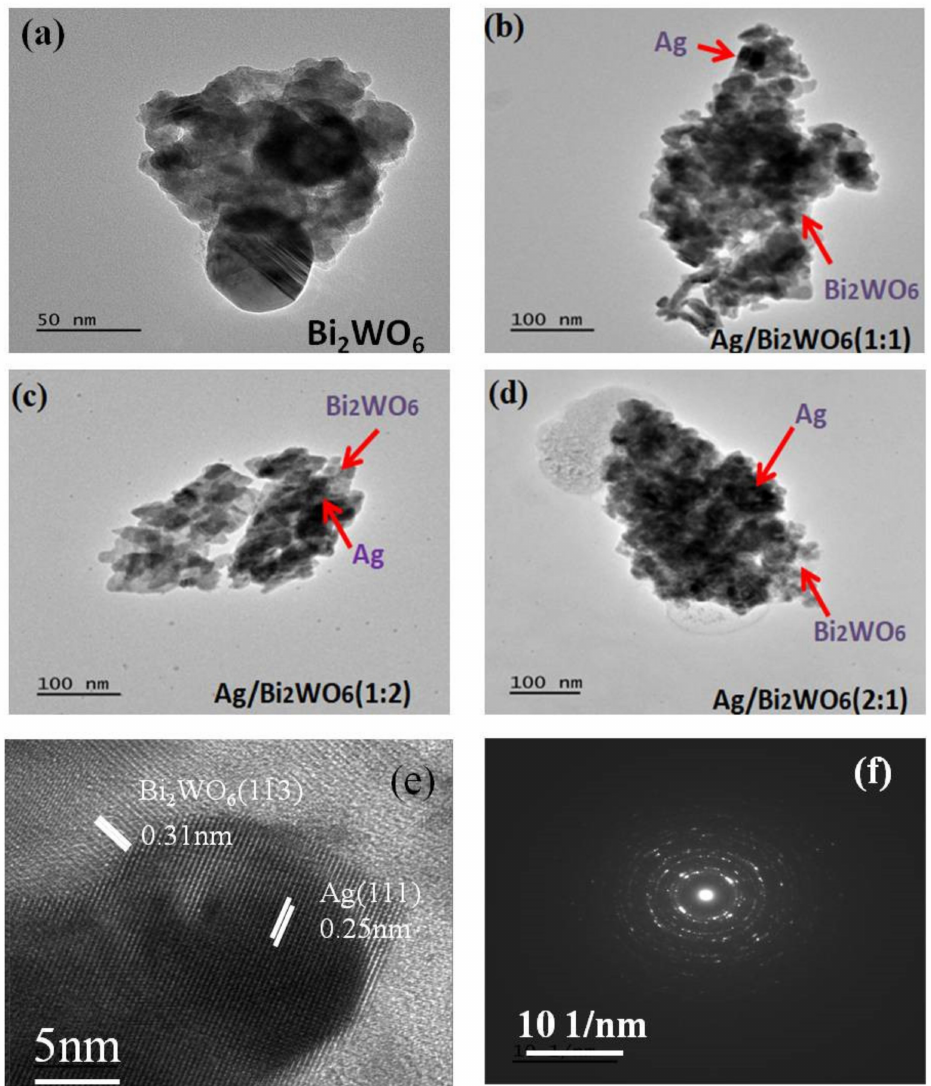
Figure 6. TEM images of ( a ) Bi 2 WO 6 , ( b ) Ag/Bi 2 WO 6 (1:1), ( c ) Ag/Bi 2 WO 6 (1:2) and ( d ) Ag/Bi 2 WO 6 (2:1); ( e ) lattice spacing of Ag/Bi 2 WO 6 (1:2); and ( f ) SAED pattern of Ag/Bi 2 WO 6 (1:2). X-ray photoelectron spectroscopy (XPS) was performed on pure Bi 2 WO 6 and Ag/Bi 2 WO 6 (1:1, 1:2 and 2:1) as shown in Figure 8. The binding energy in the spectrum was calibrated using that of C1s (284.62 eV). Figure 8 is the overall XPS spectrum of the Bi 2 WO 6 and Ag/Bi 2 WO 6 (1:1, 1:2 and 2:1) heterostructure. No peak corresponding to Ag is detected in the overall XPS spectrum of Bi 2 WO 6 , whereas composites of Ag/Bi 2 WO 6 show Ag peaks, indicating that the photodeposition method is successful for Ag deposition. The peaks centering in the region 159.23 and 164.57 eV (Figure 9a) can be designated to be the binding energies of Bi 4f 7/2 and Bi 4f 5/2 in Bi 3+